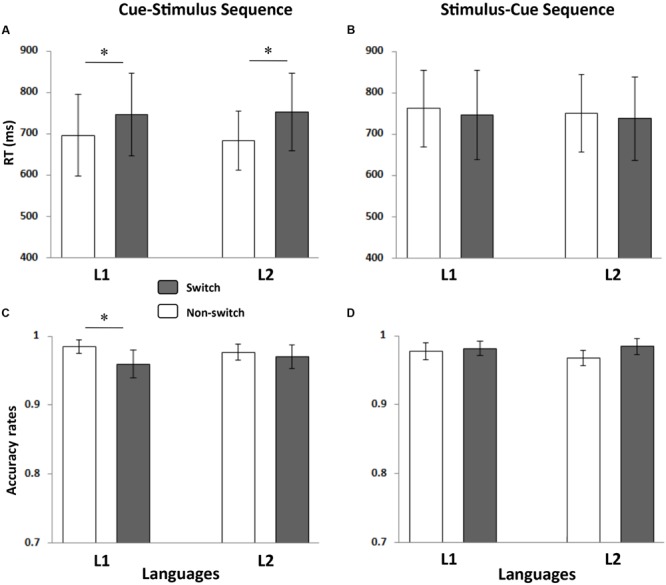
Mean RTs and ACCs for each condition. The left panel shows the mean RT (A) and ACC (C) of the cue-stimulus sequence, and the right panel presents the mean RT (B) and ACC (D) of the stimulus-cue sequence. The stars indicate a significant difference (p < 0.05). The error bars refer to standard errors (SE).